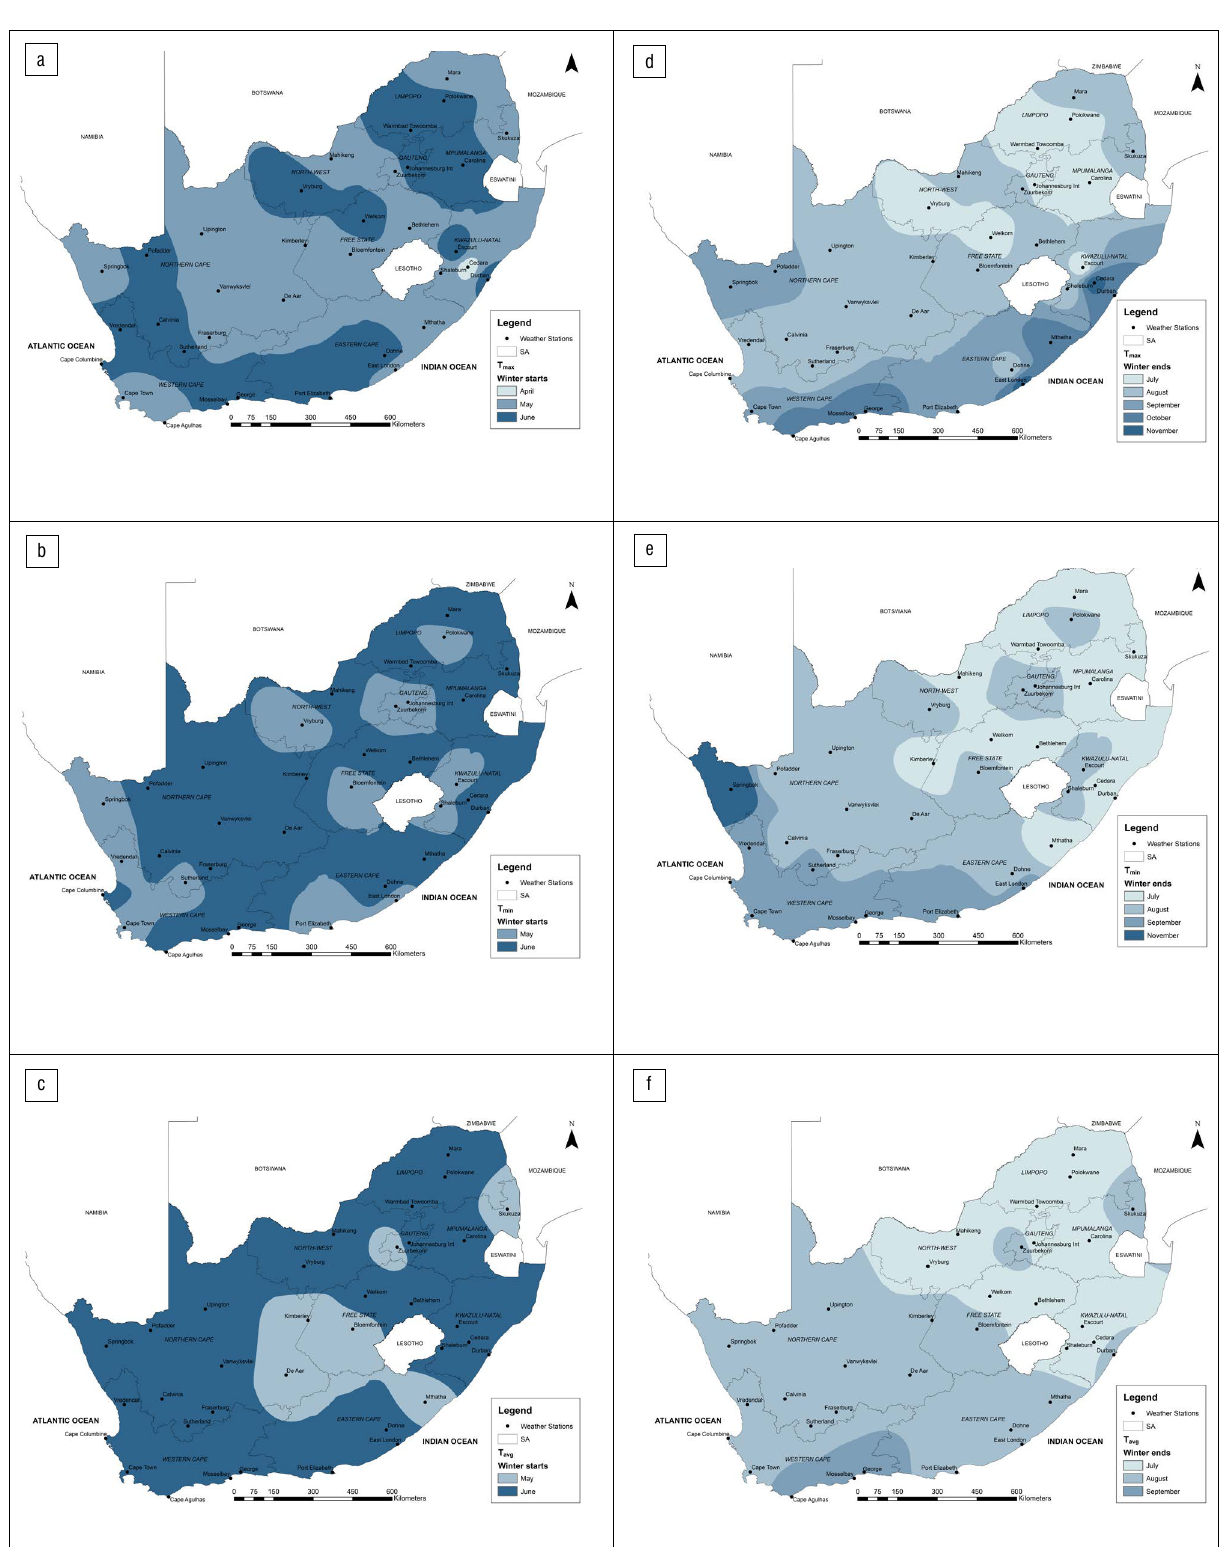
Figure 4: (a–c) Start of winter and (d–f) end of